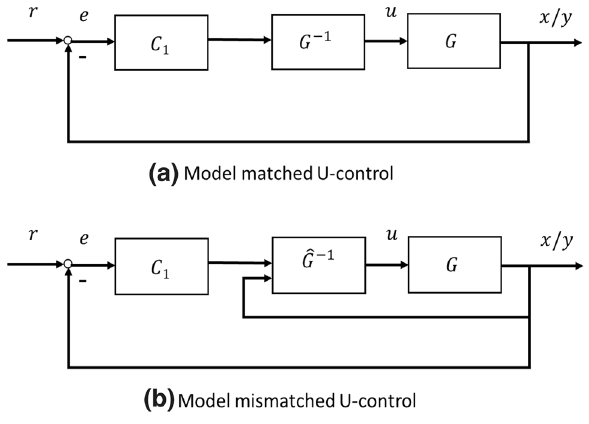
Figure 1. U-control